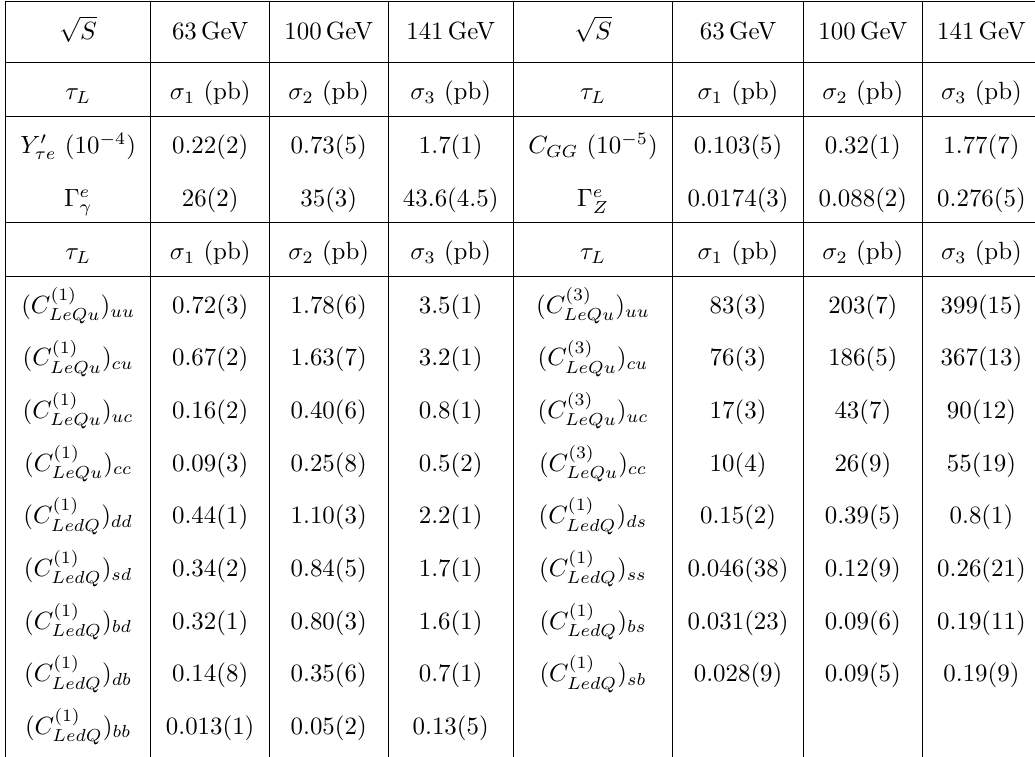
Table 2 . Numerical coefficients a iJ that control the cross sections σ i = a iJ | C J | 2 for the CLFV process ep → τX , induced by CLFV Higgs couplings, photon and Z dipoles and scalar and tensor four-fermion operators. The subscript i = { 1 , 2 , 3 } denotes each of the three benchmark points √ discussed in the text, at S = 63 , 100 , 141 GeV, respectively, while J is the operator label. Here we omit interference terms between photon and Z dipoles and between Higgs couplings, scalar and tensor four-fermion operators. The cross section is computed with the NNPDF31_lo_as_0118 PDF set. The error estimates includes PDF and scale uncertainties. We give here the cross section for the τe component of the operators, in which the τ lepton is left-handed. The results are identical for the eτ components, with the difference that a right-handed τ is